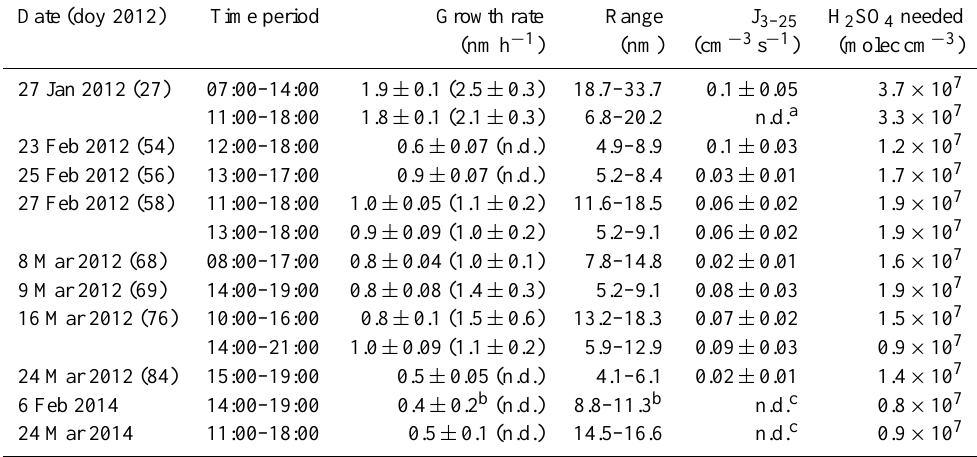
Table 1. Nucleation events of class I (Dal Maso et al., 2005) during the austral summers of 2012 and 2014: Time period during which the particle growth in the given range was observed, growth rate determined by log-normal mode fitting and maximum concentration (in parentheses) method, particle formation rate in the size range 3–25nm (J 3–25 ), and estimated H 2 SO 4 vapour concentration needed for the observed growth